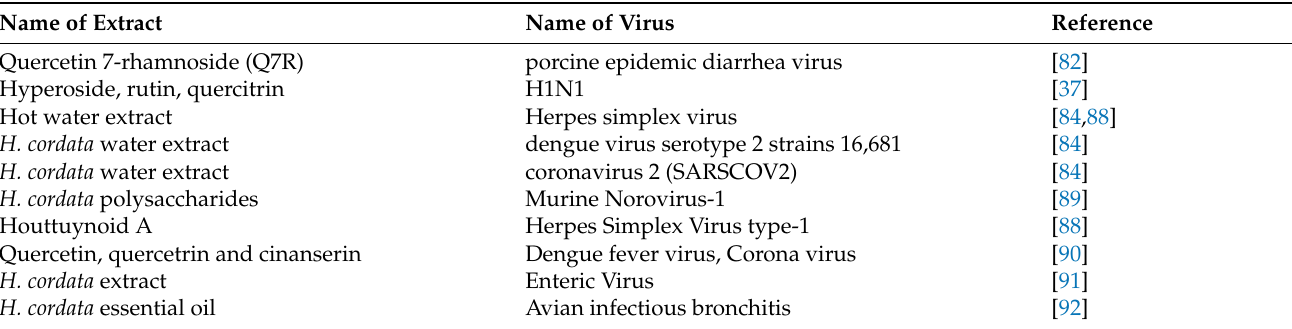
Table 4. Anti-viral effect of H. cordata